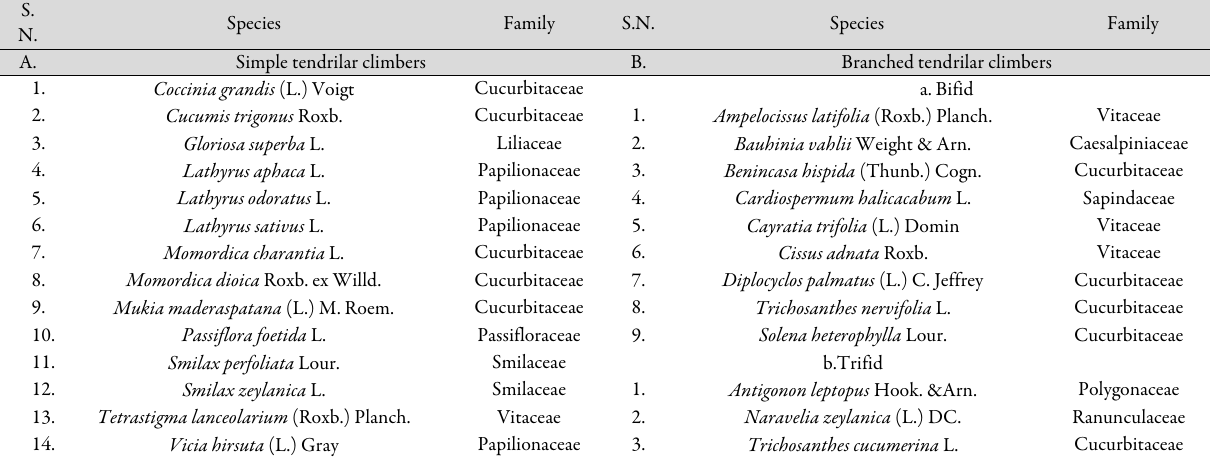
Supplementary Table 2. List of tendrilar climbers based on their branching across the terrestrial landscape of north-eastern Uttar Pradesh